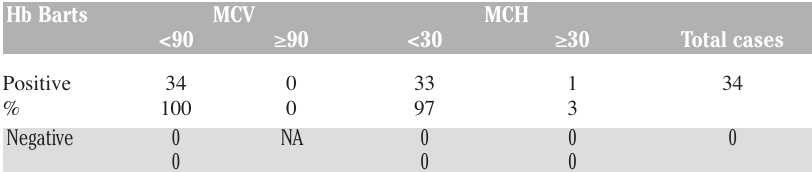
Table 1. Results on cord blood of test group.